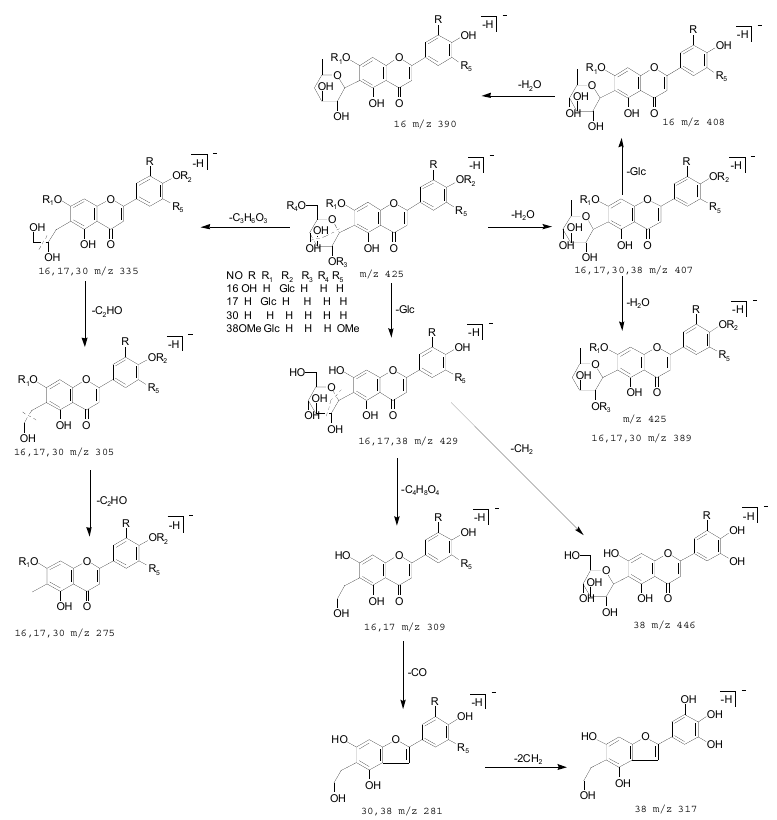
Figure 8. The proposed fragmentation pathway of saponarin, isovitexin-2 ′′ - O -B- D -glucosyle, isovitexin, isopyrenine-7- O -glucosyle, 4 ′ - O -B- D -glucospranosyl-2 ′ ’- O -[1- O -B- D -glucosyl-2,4,4- trihydroxy-( E )-cinnamoyl]-2 ′′ -isoorientin. Compounds 25 and 28 produced their [M − H + HCOOH] − ions at m / z 801.21179 and 801.21118 (C 34 H 41 O 22 , mass error = 3.391 ppm and mass error = 2.781 ppm), m / z 639.15826 and 639.15808401.10892 (C 28 H 31 O 17 , mass error = 2.684 ppm and mass error = 2.504), respectively. Both of them produced [M − H] − and [M − H + HCOOH − Glc] − ions at m / z 755, m / z 593, m / z 639 and m / z 477. Compound 25 generated a serial of ions at m / z 621 [M − H + HCOOH − Glc − H 2 O] − , m / z 477 [M − H + HCOOH − 2Glc] − , m / z 681 [M − H + HCOOH − C 4 H 8 O 4 ] − and m / z 635 [M − H − C 4 H 8 O 4 ] − [49]. Compound 28 could produce [M – H − Glc] − , [M − H + HCOOH − Glc − C 4 H 8 O 4 ] − , [M − H − C 4 H 8 O 4 ] − and [M − H − C 5 H 10 O 5 ] − at m / z 431, m / z 357, m / z 311 and m / z 281, respectively. Therefore, according to the fragmentation pathways and literature data, compounds 25 and 28 were isovitexin-2 ′′ -4 ′ - O -B- D - glucosyle, isovitexin-2 ′′ - O -B- D -glucosyle. Compounds 27 and 36 yielded their [M + H] + ions at m / z 449.10727 and 449.10684 (C 21 H 21 O 11 , mass error = 0.568 ppm and 0.998 ppm), m / z 493.13306 and 493.13287 (C 23 H 25 O 12 , mass error = 2.013 ppm and 2.398 ppm), respectively. Both of them generated [M + H − H 2 O] + and ions [M + H − 2H 2 O] + at m / z 431, m / z 475, m / z 413 and m / z 457, respectively. Compound 27 could generate a series of ions at m / z 395 [M + H − 3H 2 O] + , m / z 329 [M + H − C 4 H 8 O 4 ] + and m / z 299 [M + H − C 5 H 10 O 5 ] + [50,51]. Compound 36 displayed fragment ions at m / z 315, m / z 313 and m / z 195 corresponding to [M + H − C 10 H 10 O 3 ] + , [M + H − C 5 H 10 O 5 − HCHO] + and [M + H − C 5 H 10 O 5 − C 10 H 10 O 3 ] + respectively. By comparing with the literature data, compounds 27 and 36 were tentatively annotated as isoorientin and 6- C -B- D - glucospranosyltricine (isopyrenine). Compounds 39 and 46 produced their [M − H + CH 3 COOH] − ions at m / z 683.18146 (C 30 H 35 O 18 , mass error = 0.484 ppm) and m / z 521.12724 (C 24 H 25 O 13 , mass error = 1.653 ppm). Both of the deprotonated molecular ions yield [M − H + CH 3 COOH − H 2 O] − at m / z 503 and m / z 665. Compound